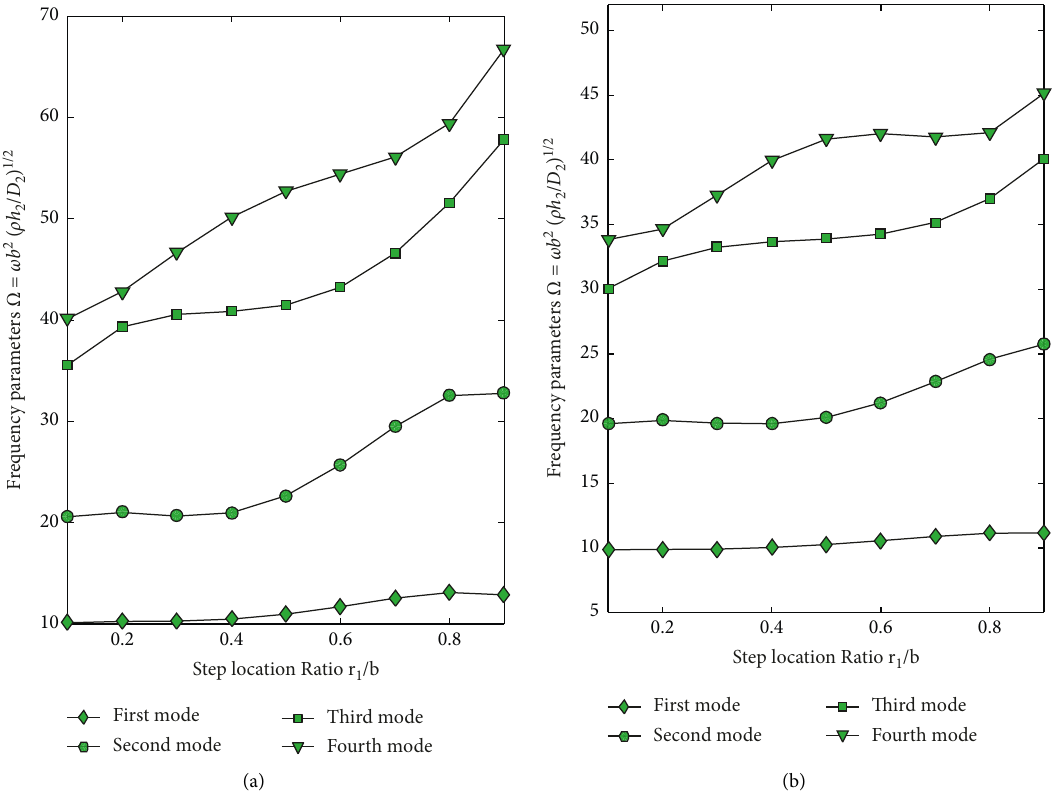
������ 􏽰 ρ h versus step location ratio r / D 2 2 / b � (a) 0.006 and (b) 1